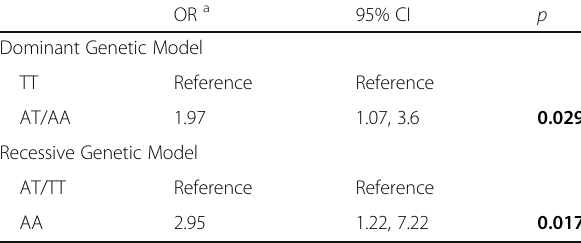
Table 2 Association between FTO genotypes and MetS risk OR a 95% CI